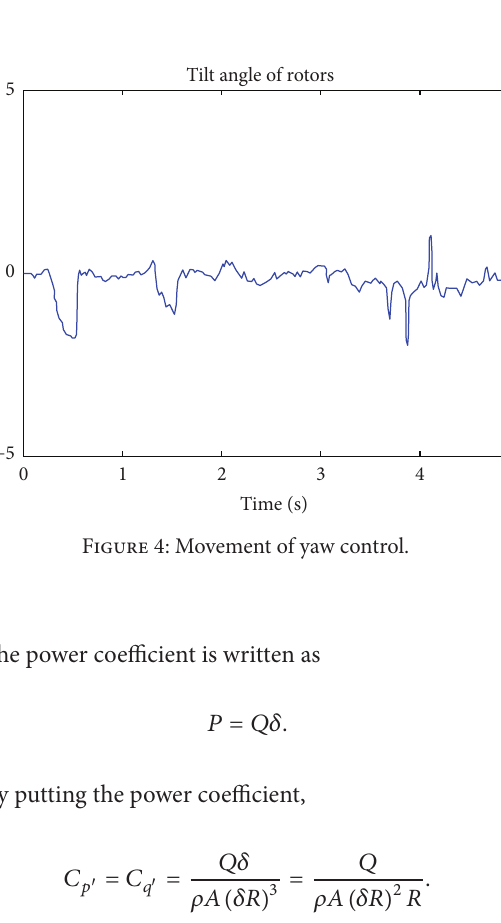
Figure 3: Pitch Control Strategy with respect to Nose-Up (a) and Nose-Down (b) conditions.